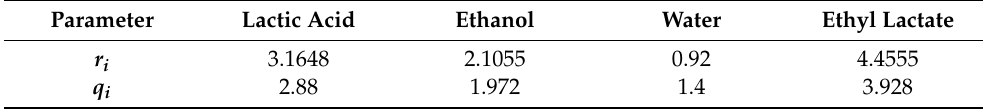
Table A2. UNIQUAC volume and area parameters.